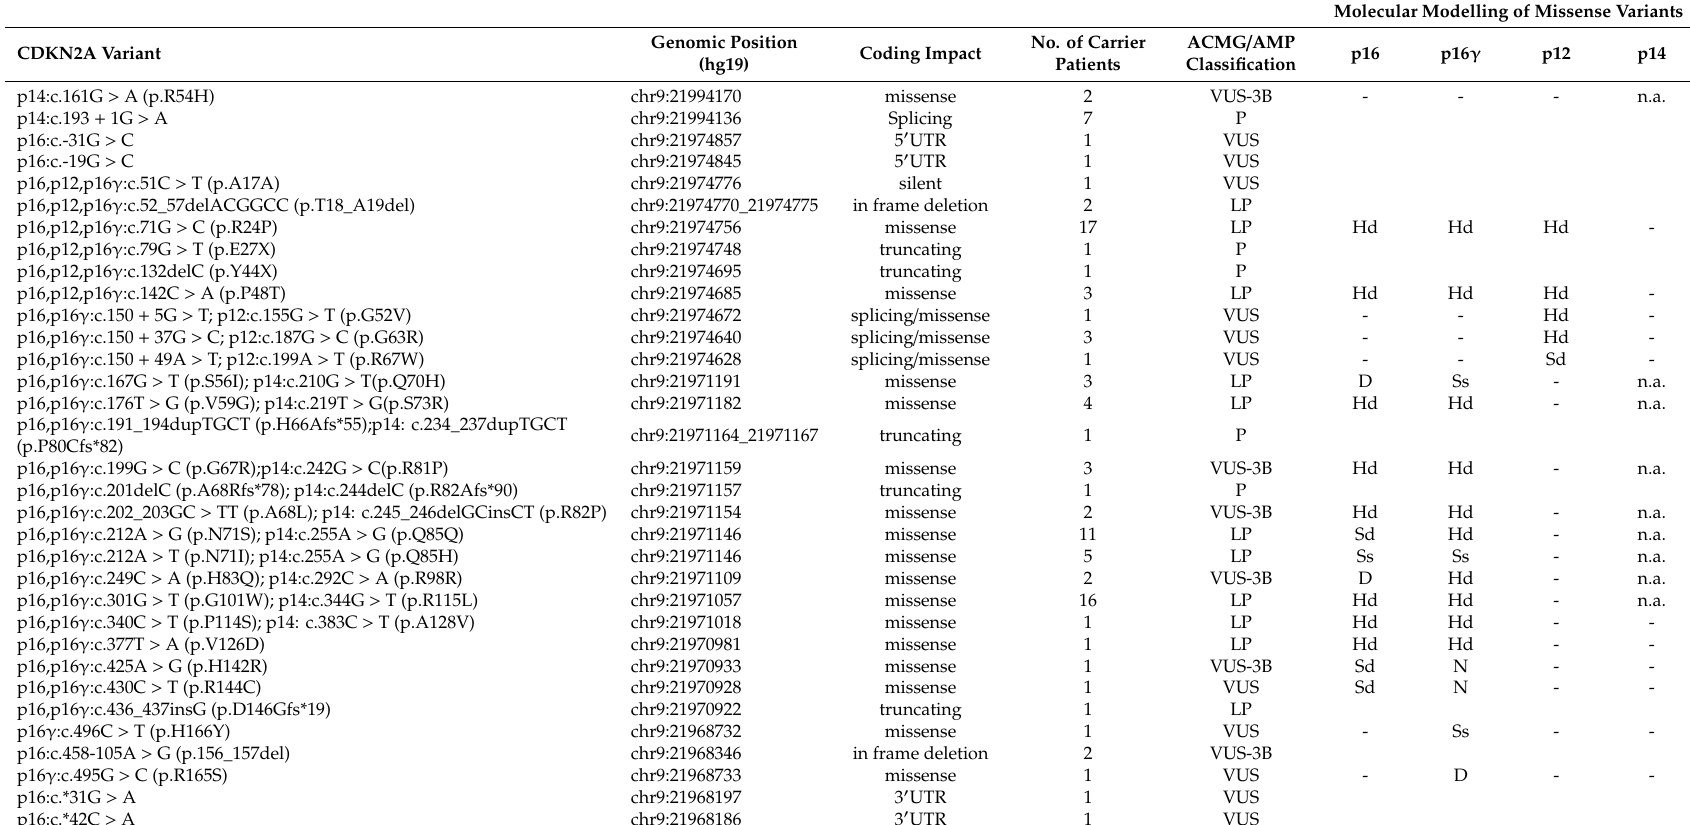
Table 3. DNA variant identified in CDKN2A